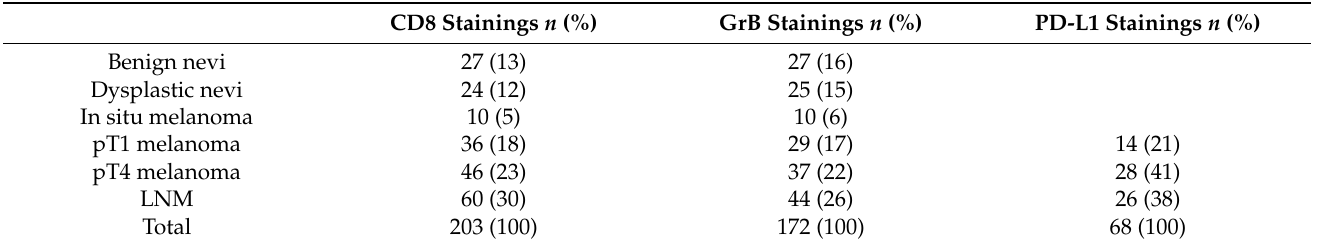
Table 1. Sample sizes of analyzed CD8, GrB and PD-L1 stainings. pT = pathological tumor stage, LNM = lymph node metastasis.